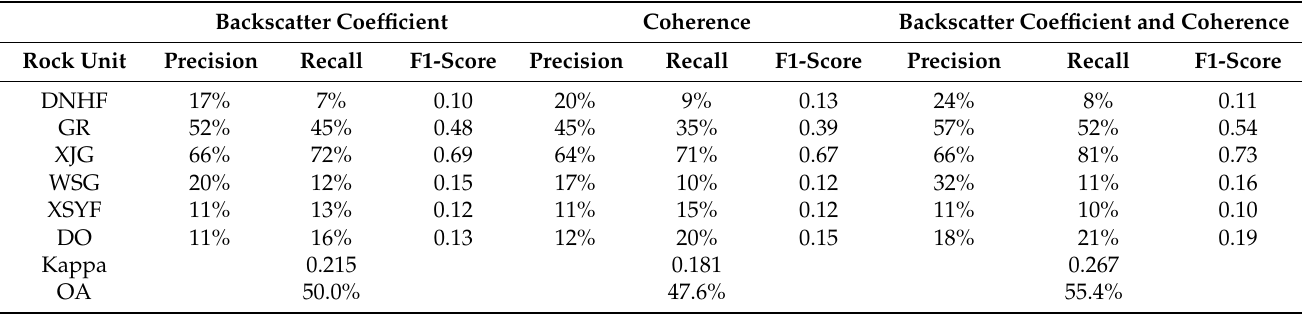
Table 6. Accuracy assessment of the result using backscatter coefficient (accessed on 28 May), coherence (accessed on 16 May and 28 May), and both backscatter coefficient and